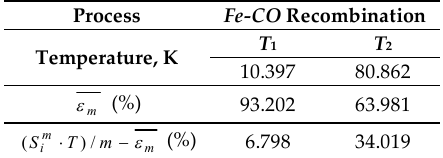
Table 4. Reaction efficiency of Fe-CO bond recombination in β-hemoglobin for various temperatures. Process